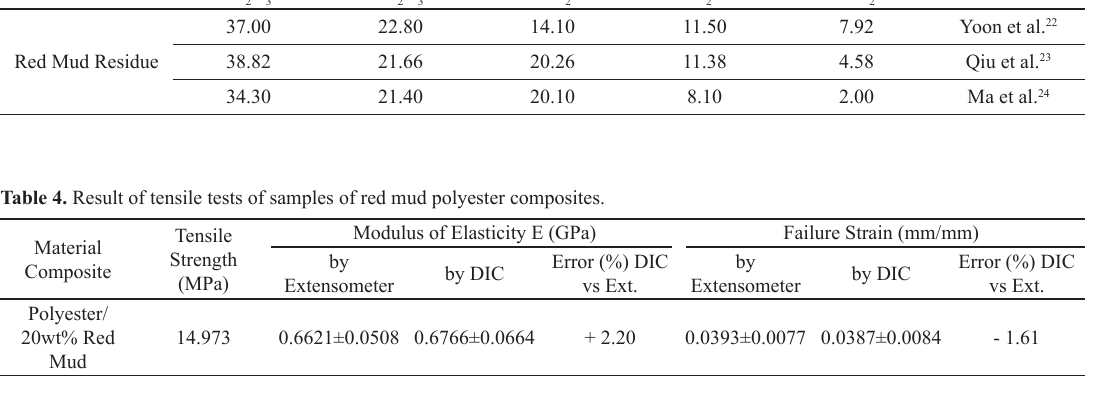
Table 3. Main nominal compositions (amount % mass), in oxides, red mud residue presented in the literature. Residue